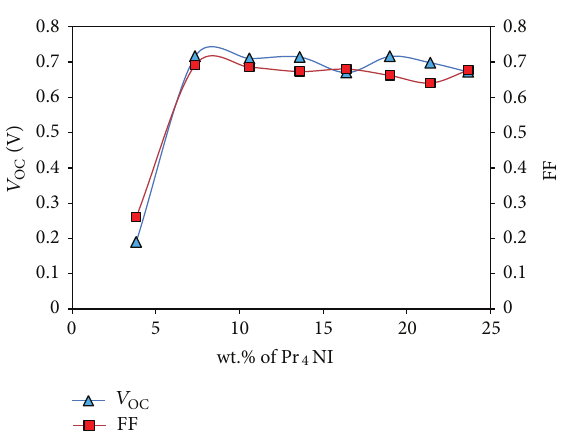
Figure 5: Effects of weight percentage of Pr 4 NI salt in the electrolyte on open circuit voltage and fill factor of DSSCs.